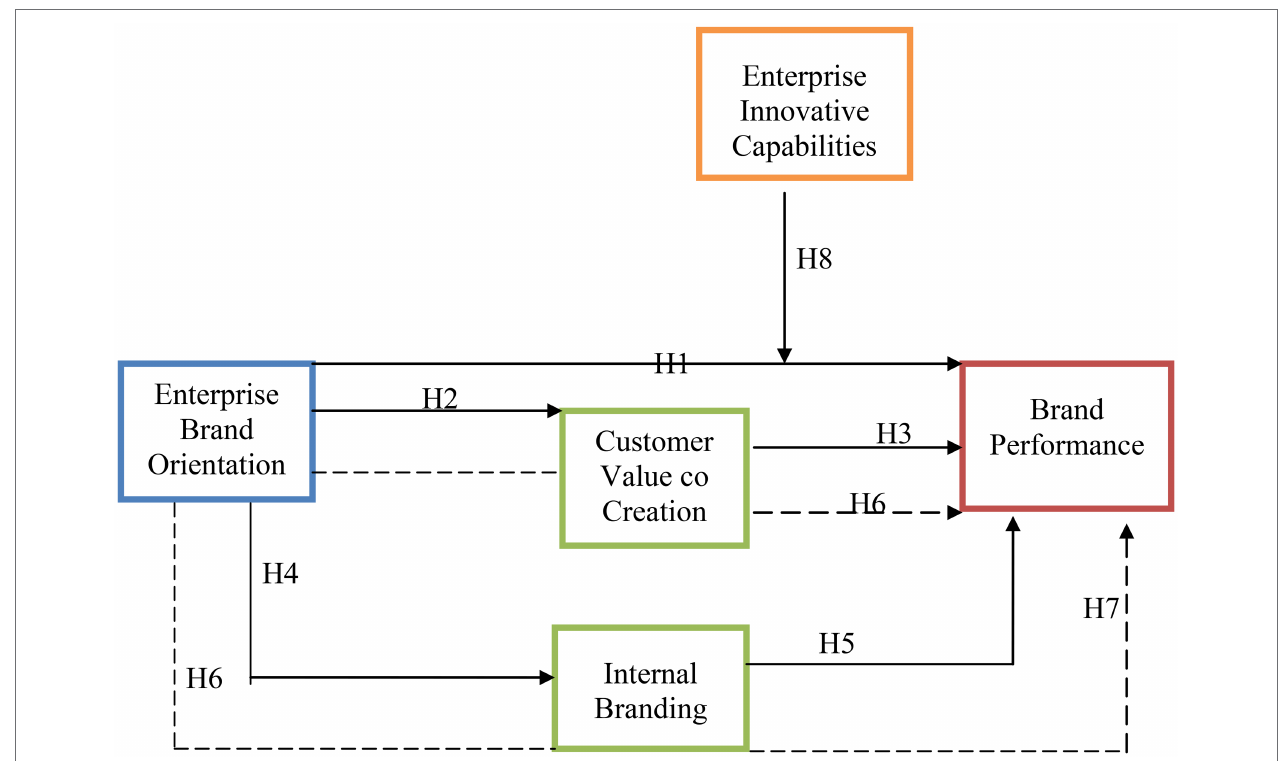
FIGURE 1 | Conceptual